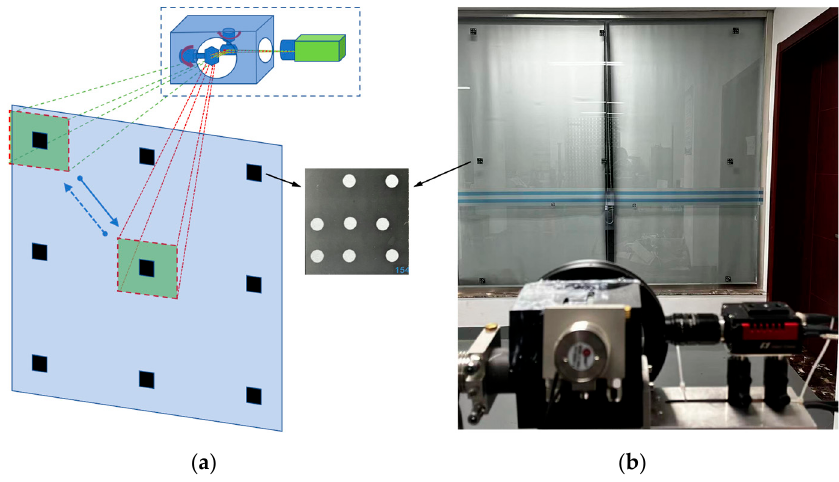
Figure 10. The experiment of galvanometer scanner repeatability. ( a ) The schematic diagram of the galvanometer repeatability experiment. ( b ) The scene of the repeatability experiment. The pixel coordinates of the coded point centers in the images were extracted. The deviations among the five pixel coordinates of the same coded point center corresponding to the same D ( a , b ) were calculated. The mean absolute (MA) and root mean square (RMS) s deviations in the pixel are shown in Table 1. Table 1. The pixel errors of coded points captured by the VMOS at the same galvanometer deflection. MA (Pixel)